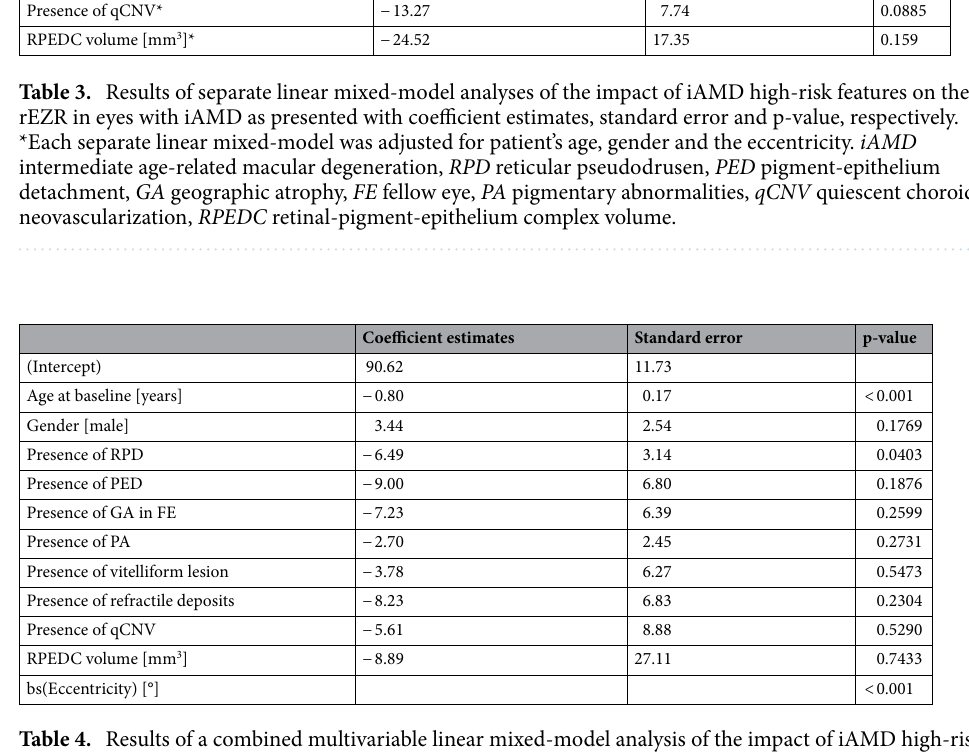
Table 4. Results of a combined multivariable linear mixed-model analysis of the impact of iAMD high-risk features on the rEZR in eyes with iAMD as presented with coefficient estimates, standard error and p-value, respectively. iAMD intermediate age-related macular degeneration, RPD reticular pseudodrusen, PED pigment-epithelium detachment, GA geographic atrophy, FE fellow eye, PA pigmentary abnormalities, qCNV quiescent choroidal neovascularization, RPEDC retinal-pigment-epithelium complex. Eccentricity is included as a b-spline with degree 2. The full models can be found in the supplementary material.